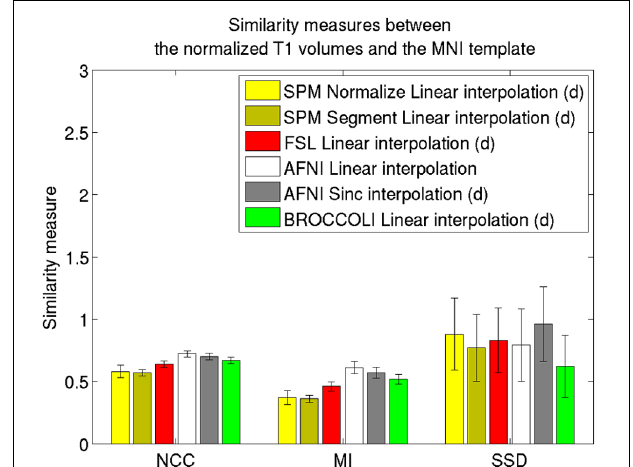
FIGURE 4 | Similarity measures between each normalized T1 volume and the MNI template for the different software packages, averaged over 198 subjects. The error bars represent the standard deviation. NCC stands for normalized cross correlation (higher is better), MI stands for mutual information (higher is better) and SSD stands for sum of squared differences (lower is better). For visualization purposes, the SSD similarity measure was divided by 300,000. Only the voxels in the MNI brain mask were used to calculate these similarity measures, as 75% of the voxels are outside the brain. Different interpolation modes were tested, as the software packages have different default settings for interpolation (d denotes the default